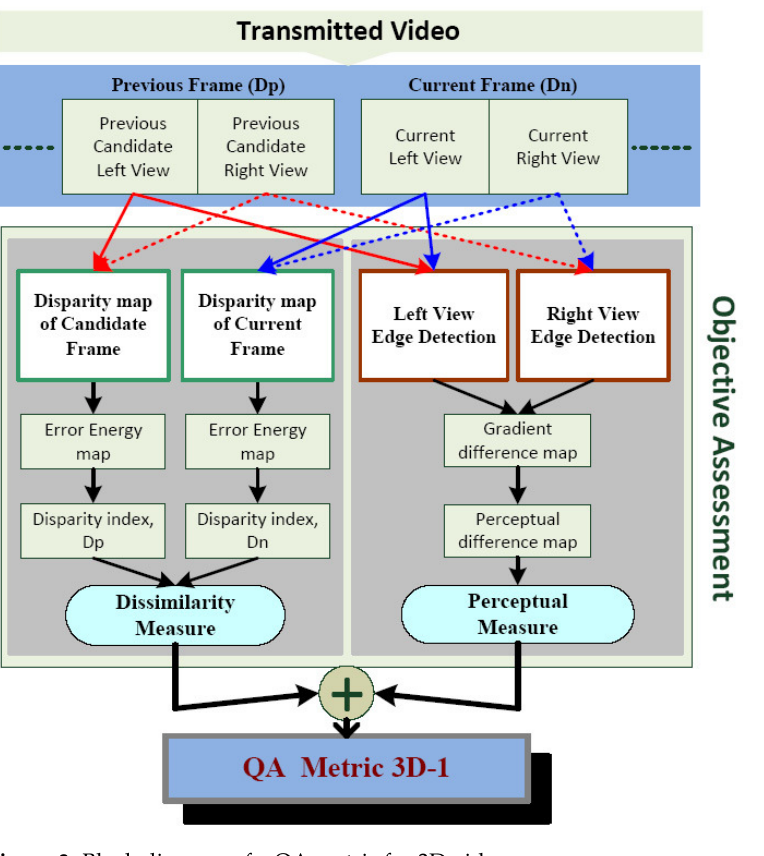
Figure 3. Block diagram of a QA metric for 3D video.